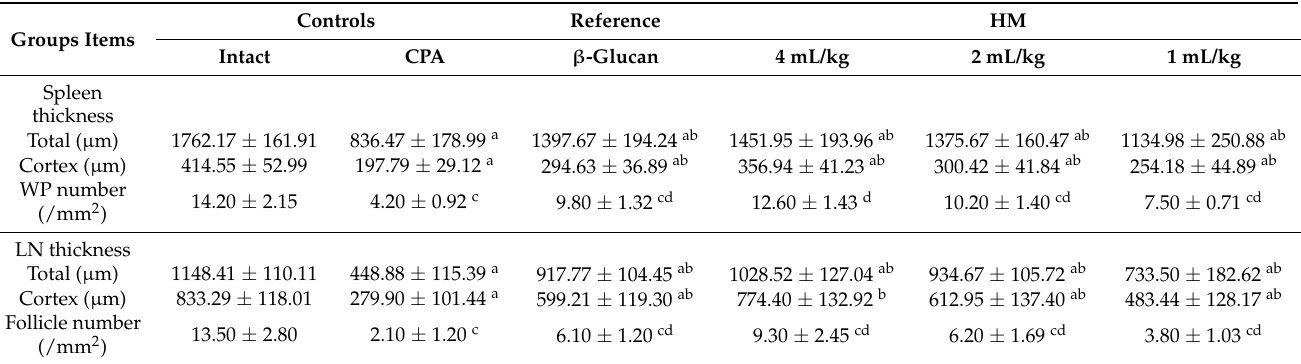
Table 4. Histomorphometrical analysis of response to hemomine treatment in intact or CPA-induced immunosuppressed mice.